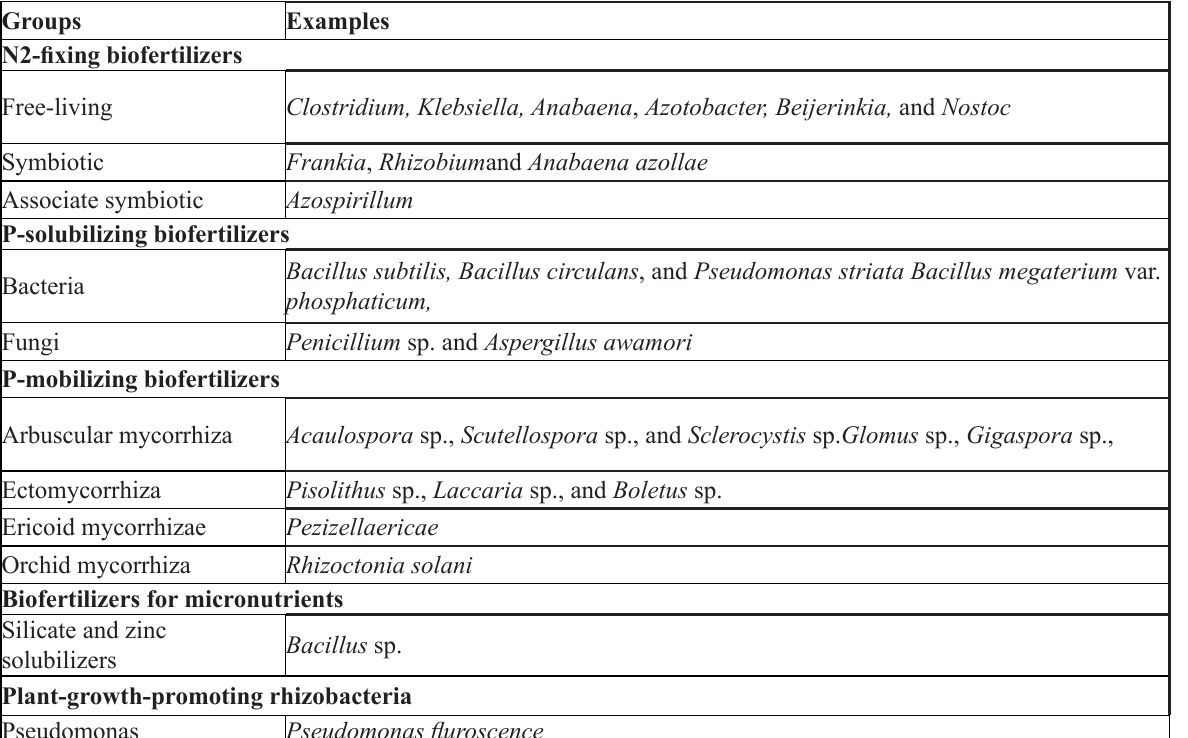
Table 1. Categorization of biofertilizers according on their functions